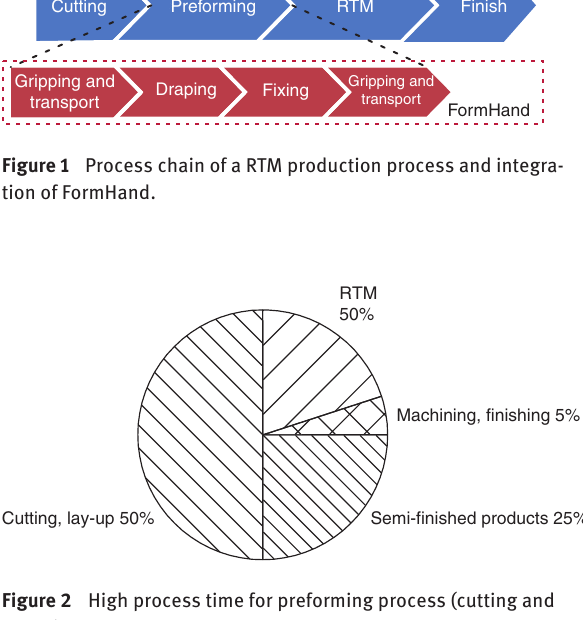
Figure 2 High process time for preforming process (cutting and lay-up)